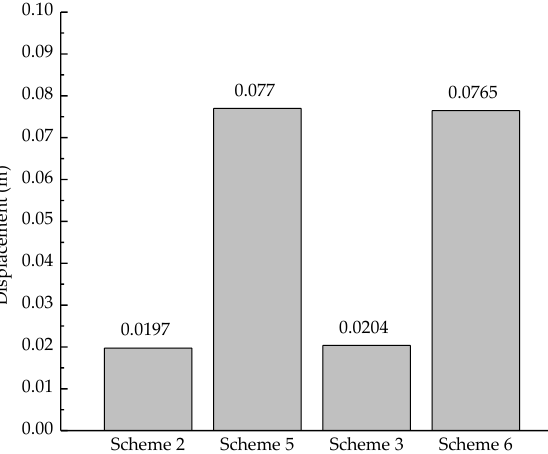
Figure 11. Comparison of the lateral displacement at the top of the side towers.